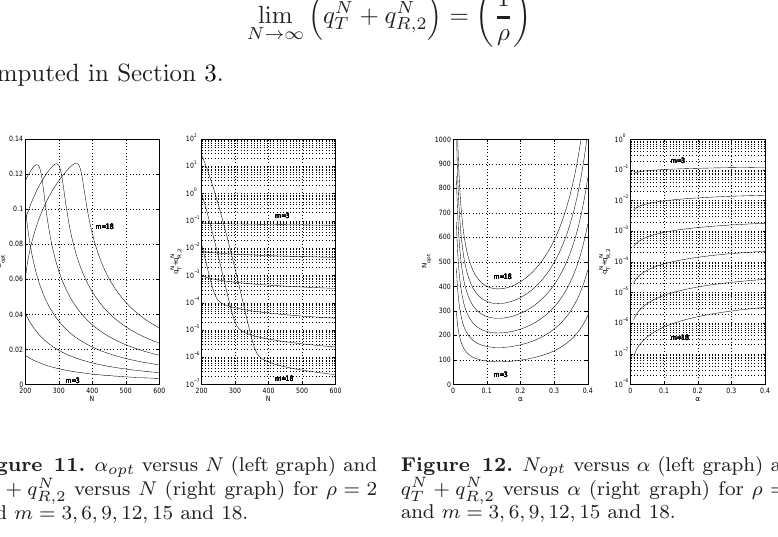
Figure 11. α opt versus N (left graph) and q N q N N (right graph) for ρ = 2 T + R, 2 versus and m = 3 , 6 , 9 , 12 , 15 and 18 .